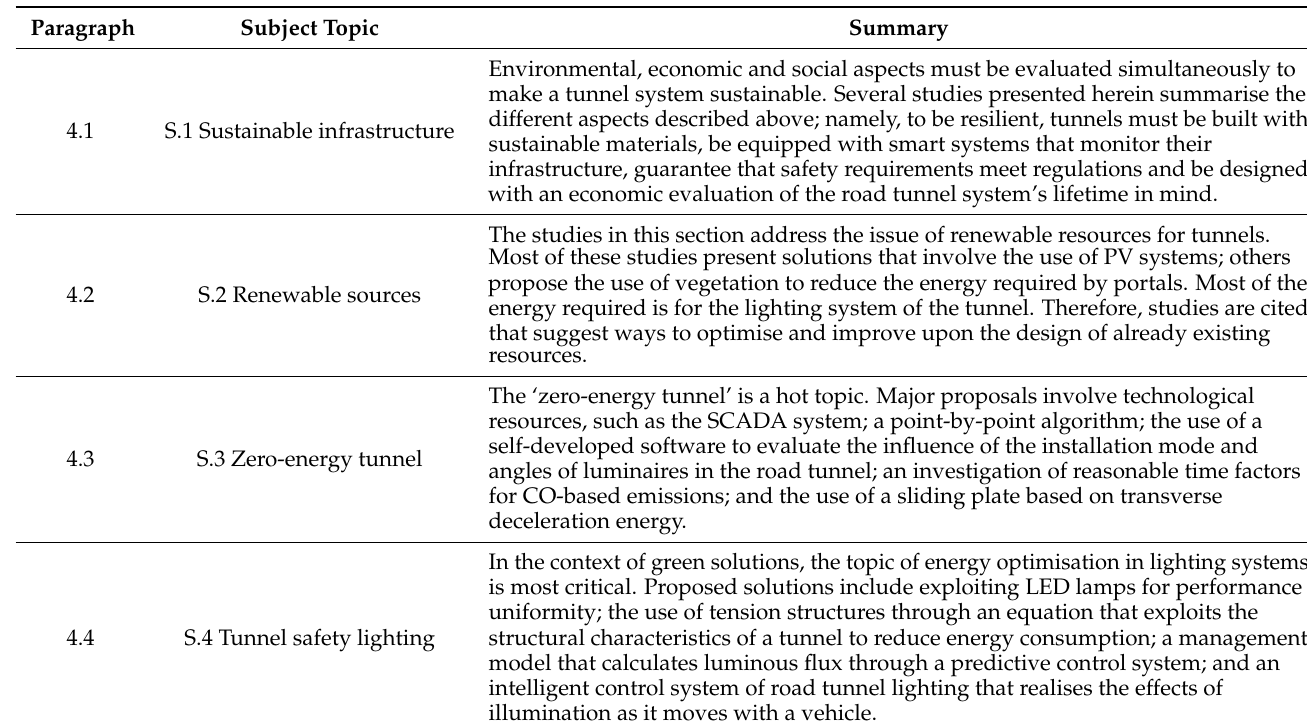
Table 7. Summary of subject topic